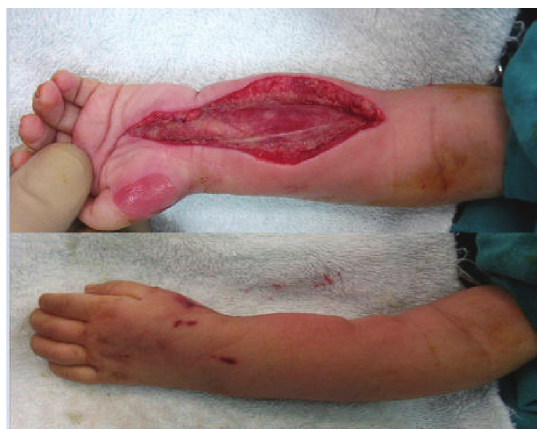
Figure 2: Intraoperative images of the volar fasciotomy and dra- matic change of the color due to adequate vascularization of com- pression area.